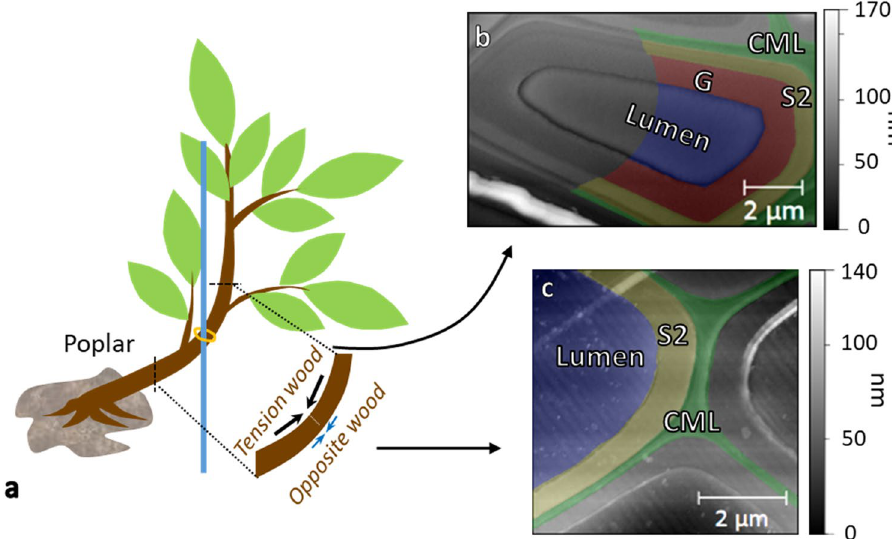
Figure 1. ( a ) Scheme of the tension generation in young poplar trees. ( b , c ) AFM topographic images of embedded and ultra-microtomed transverse cuts of tension wood fiber ( b ) and opposite wood fiber ( c